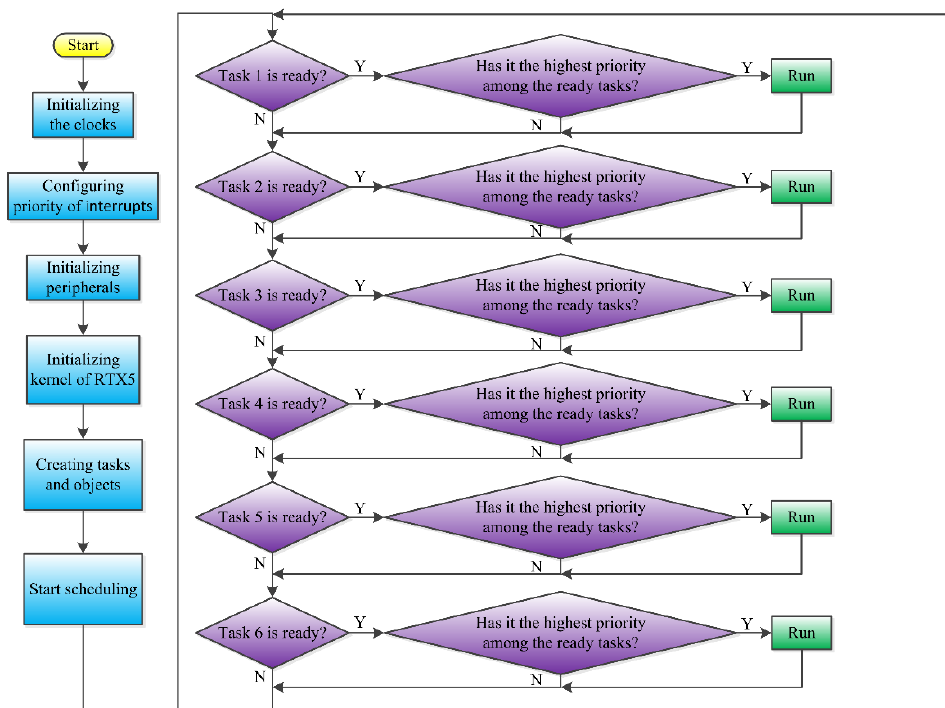
Figure 1. Flow chart of the code for regulating the laser driver.